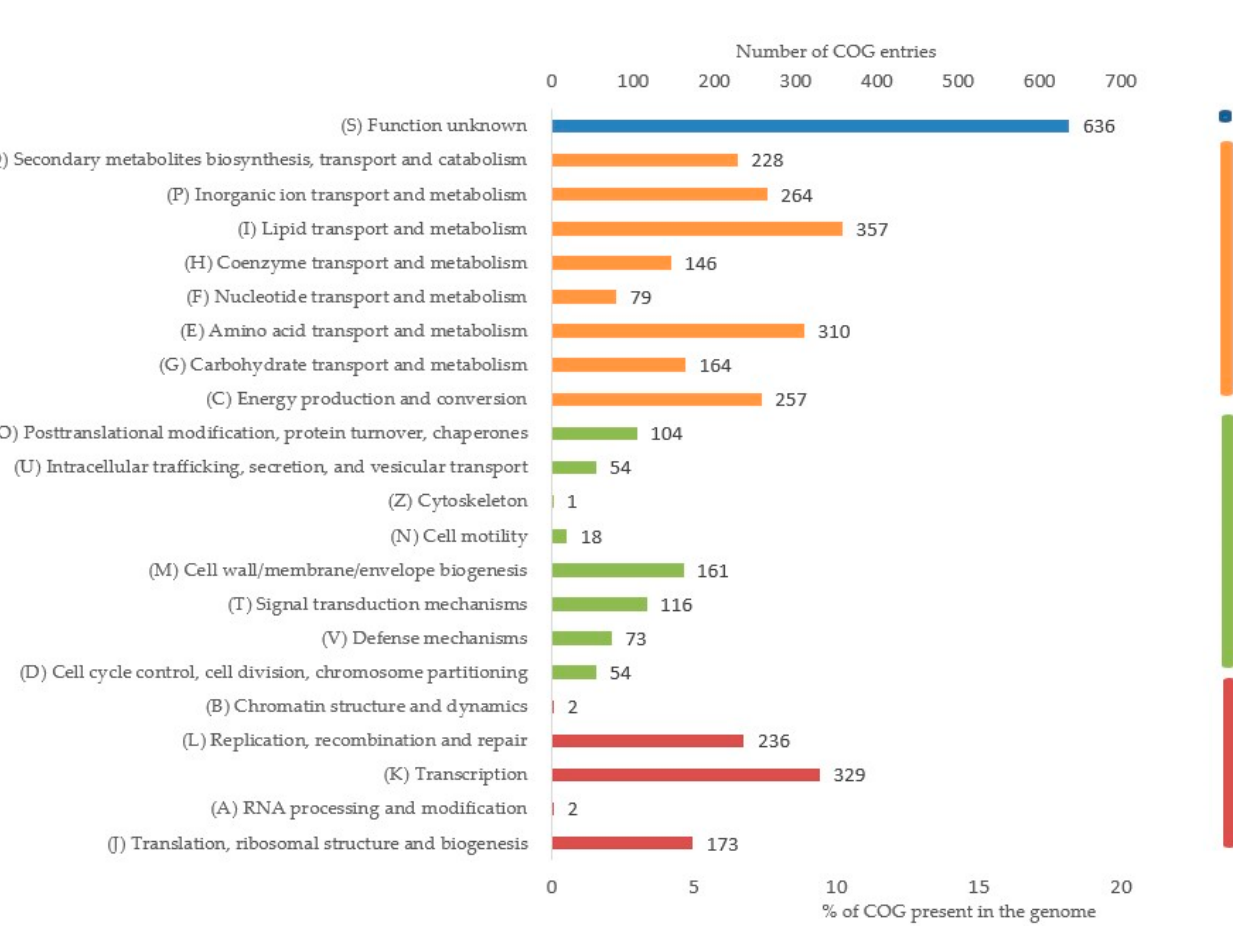
Figure 7. The cluster of ortholog groups (COGs) present in D. psychralcaliphila JI1D involved in unknown functions ( a ), metabolism ( b ), cellular and signaling processes ( c ), and genetic information processes ( d ).